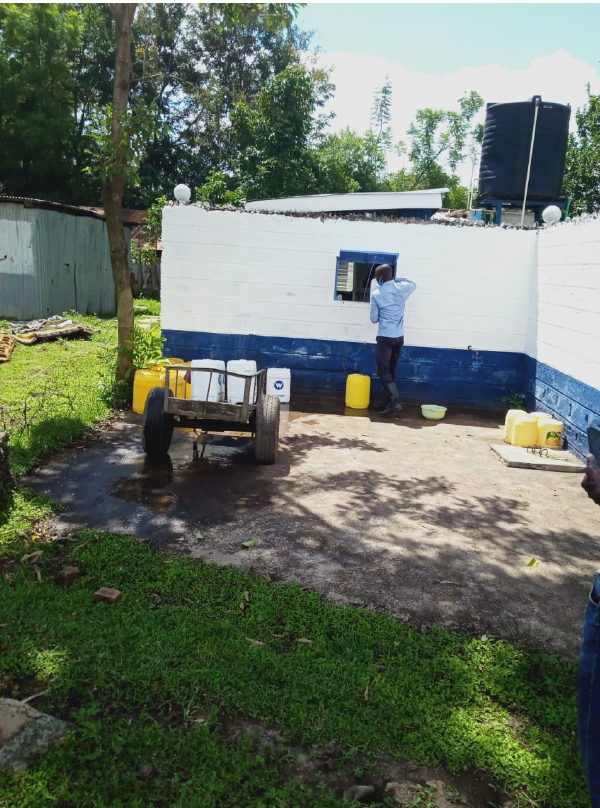
Figure 4. Ozone generators in the utility